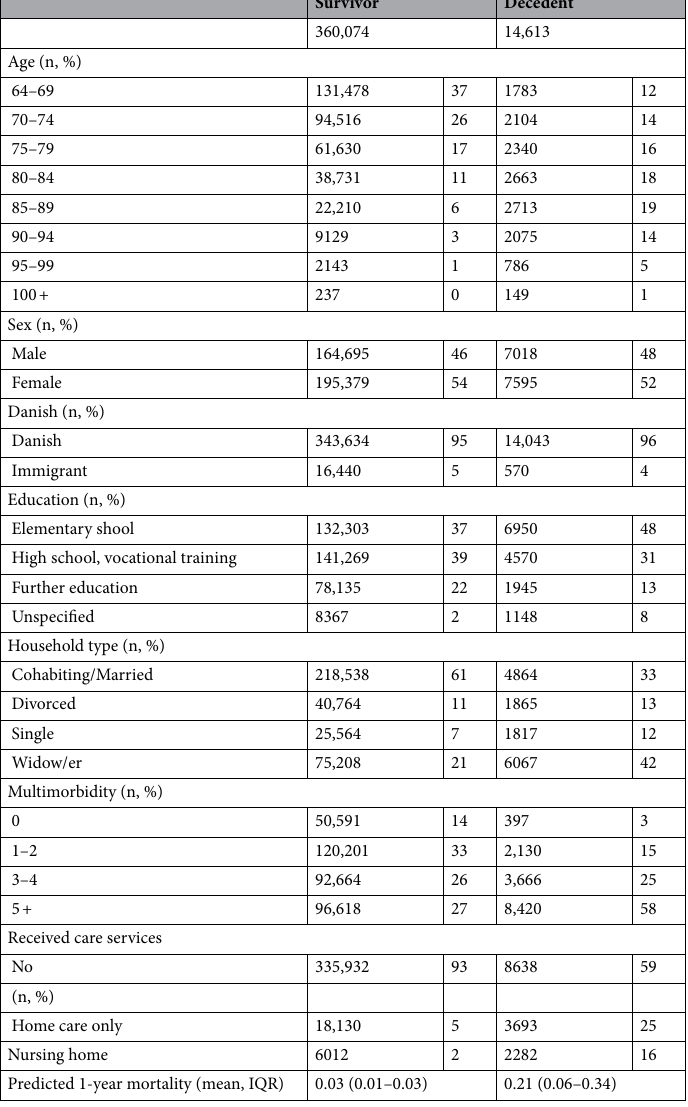
Table 1. Characteristics of the test sample used for calculating health care expenditures by predicted